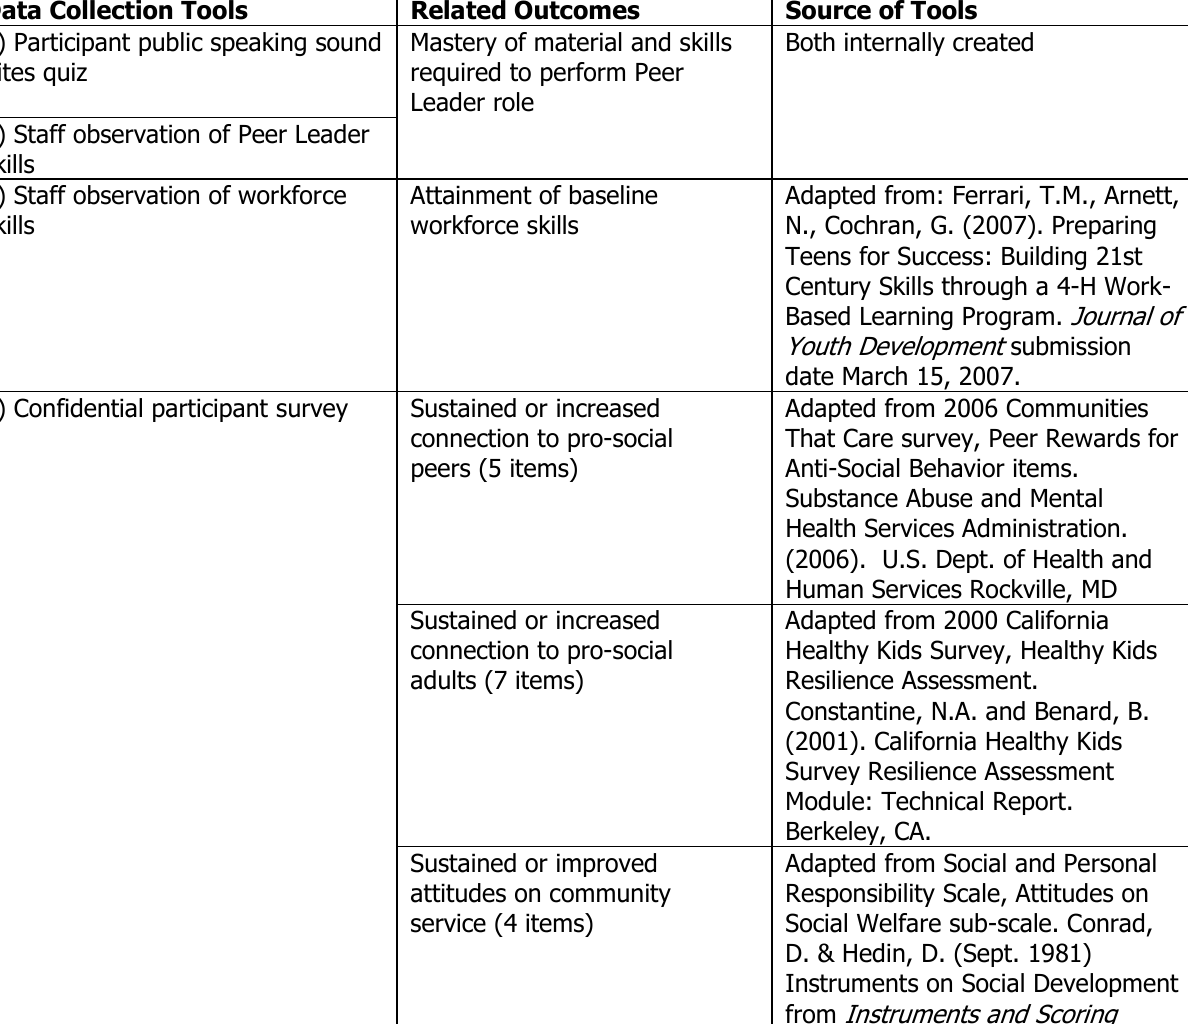
Data Collection Tools, Related Outcomes, & Sources of Tools for Crozer-Chester Medical Center’s Peer Leader Program